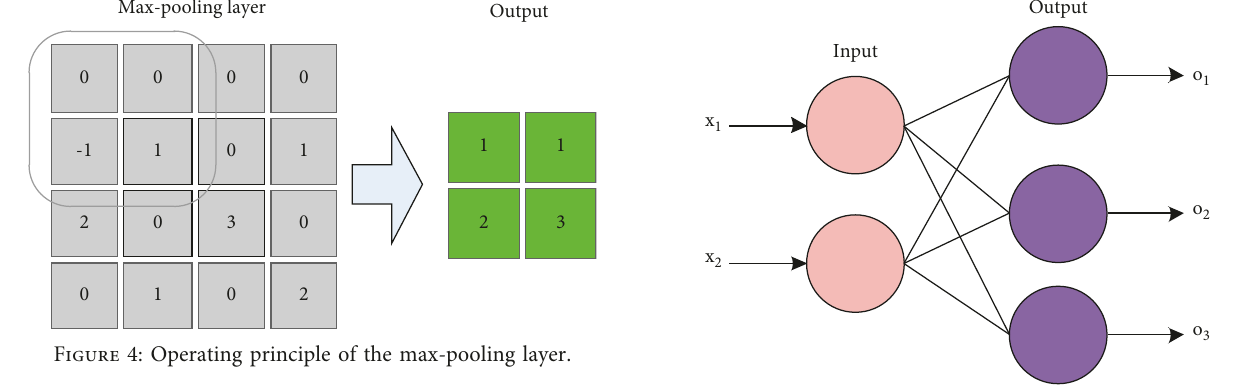
Figure 5: Schematic diagram of fully connected layers.